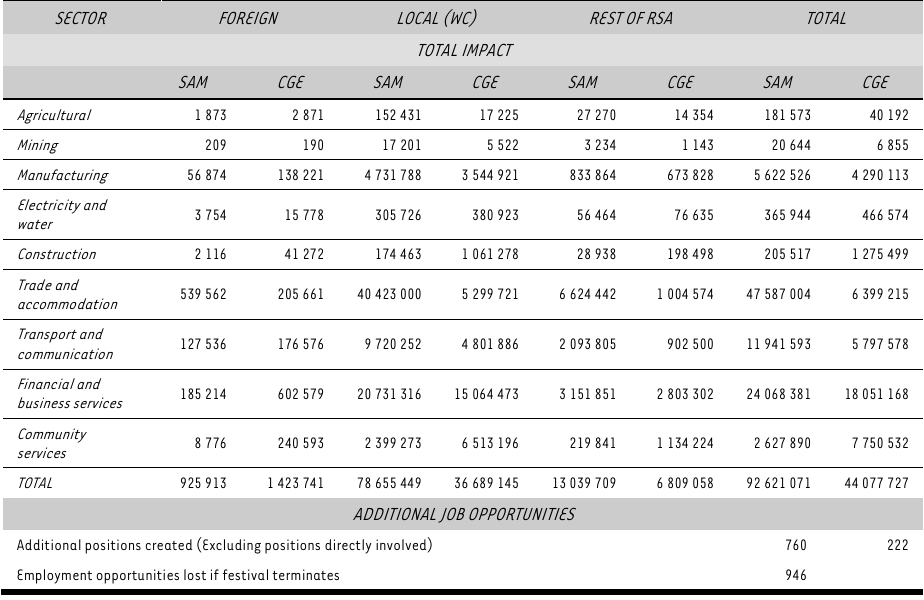
TABLE 13: Economic impact summary when applying a SAM and CGE model to the KKNK – foreign, local, rest of South Africa and total